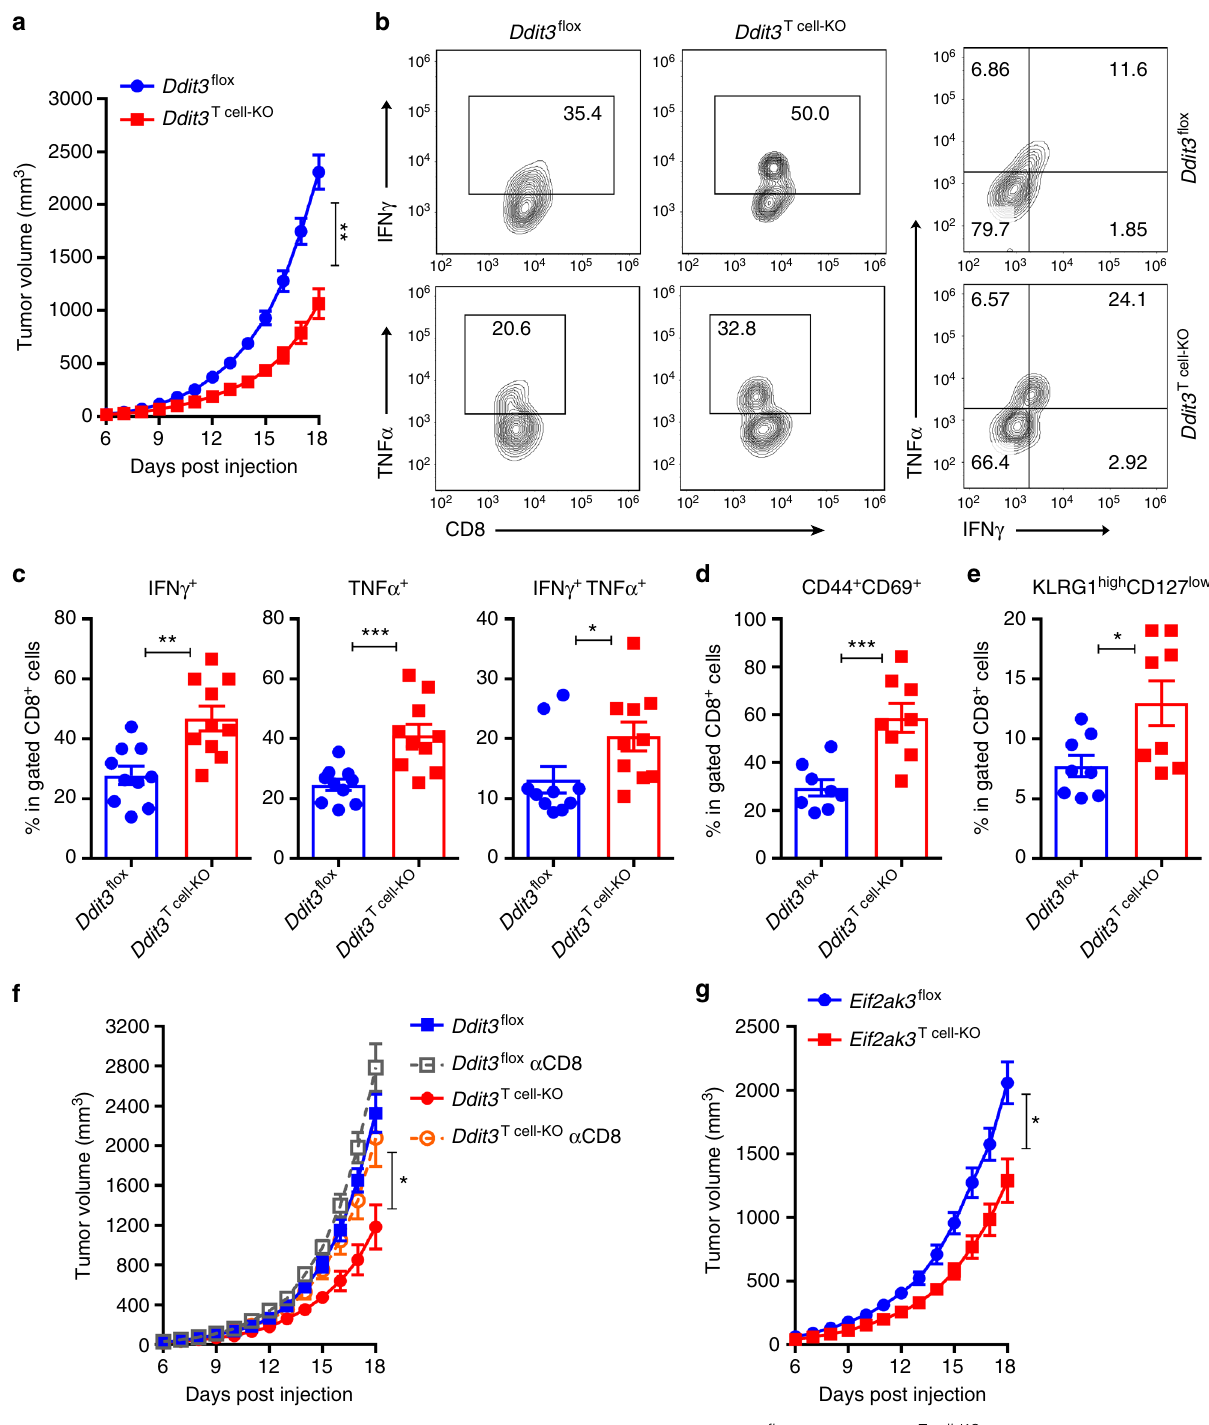
Fig. 5 Ddit3 null T cells exert promoted protective antitumor immunity. a Tumor growth in Ddit3 fl ox (blue) or Ddit3 T cell-KO (red) mice bearing B16 tumors. Average kinetics± s.e.m ( n = 15 mice/group). b Left: Representative result of IFN γ + (upper panel) and TNF- α + (lower panel), and right: IFN γ + TNF- α + in gated CD45 + CD8 + TILs from Ddit3 fl ox or Ddit3 Tcell-KO mice bearing B16 tumors. Tumors were collected 18 days after B16 tumor injection. ( n = 10 tumors/ group). c Percentage of IFN γ + (left), TNF- α + (middle) and IFN γ + TNF- α + (right) CD8 + tumor-in fi ltrating T lymphocytes (TILs) in B16 tumors isolated from Ddit3 fl ox or Ddit3 T cell-KO mice. ( n = 10 mice/group). d Frequency of CD44 + CD69 + effector CD8 + TILs in B16 tumors isolated from Ddit3 fl ox or Ddit3 T cell- KO mice. ( n = 8 tumors/group). e Percentage of KLGR1 high CD127 low late effector CD8 + TILs in B16 tumors isolated from Ddit3 fl ox or Ddit3 Tcell-KO mice. ( n = 8 tumor/group). f B16 tumor growth in Ddit3 fl ox (blue) or Ddit3 T cell-KO (red) mice, with or without 400 µ g α -CD8 antibody injection on every third day (green or orange, respectively). Average tumor volume kinetics± s.e.m in 6 mice/group. g Tumor growth in Eif2ak3 fl ox (blue) or Eif2ak3 T cell-KO (red) mice bearing B16 tumors. Average kinetics of tumor volume ± s.e.m in 8 mice/group. In the bar graphs showing mean ± s.e.m., * p < 0.05, ** p < 0.01, *** p < 0.001 were calculated using two-tailed unpaired Student ’ s t